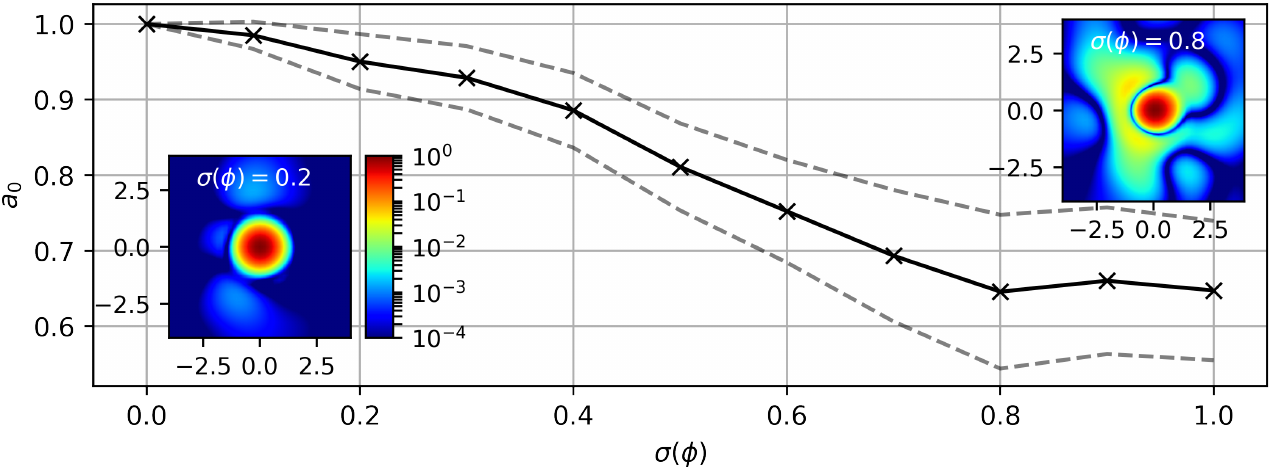
Figure 7. Evolution of the peak amplitude a 0 at focus as a function of the standard deviation of the initial phase ( σ ( φ ) in radian, solid line) and standard deviation of a 0 over 20 runs (dashed lines). Inlets exhibit examples of the normalized transverse intensity profile obtained at focus for two different values of σ ( φ ) . Transverse directions are normalized to λ